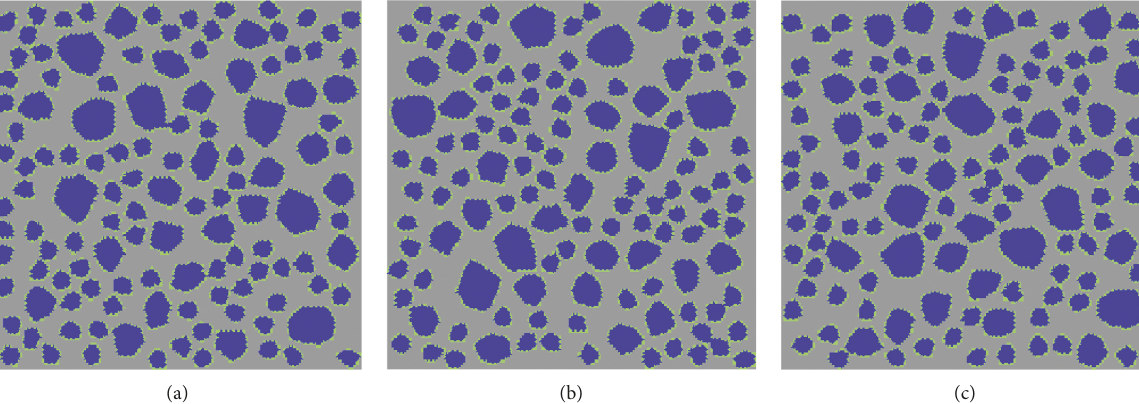
Figure 17: Random aggregate model of concrete with different aggregate distributions. (a) Specimen 1. (b) Specimen 2. (c) Specimen